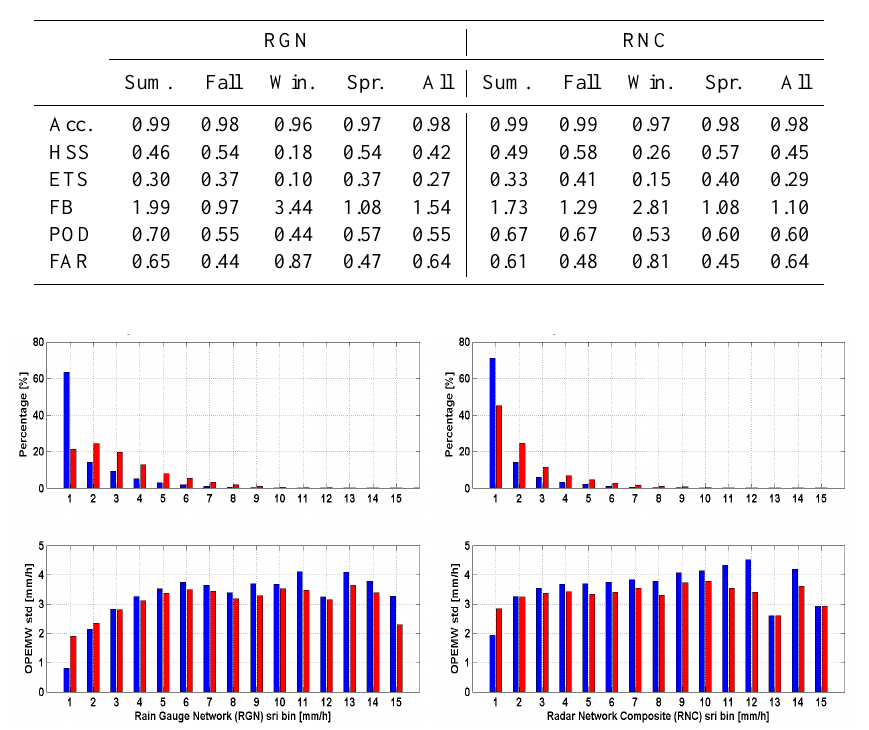
Table 1. Results of the dichotomous statistical assessment for OPEMW sri product with respect to RGN (blue) and RNC (red) products.